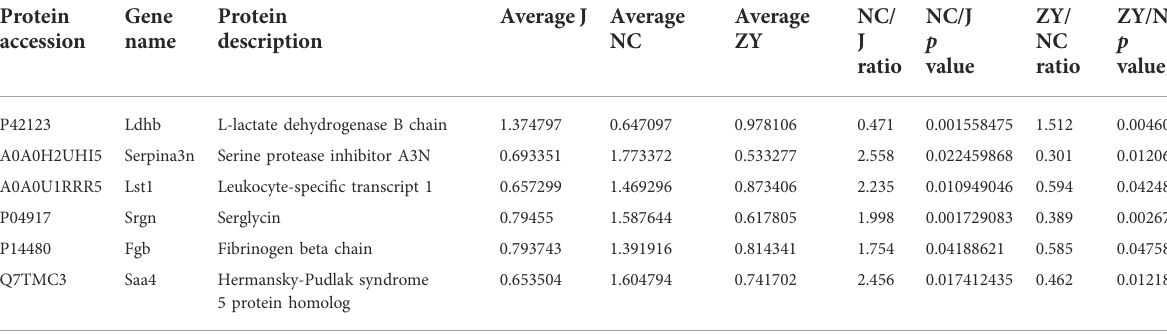
TABLE 3 Changes in the tissue of rat vertebrae proteins between NC group vs. J group and ZY group vs. NC group. Protein